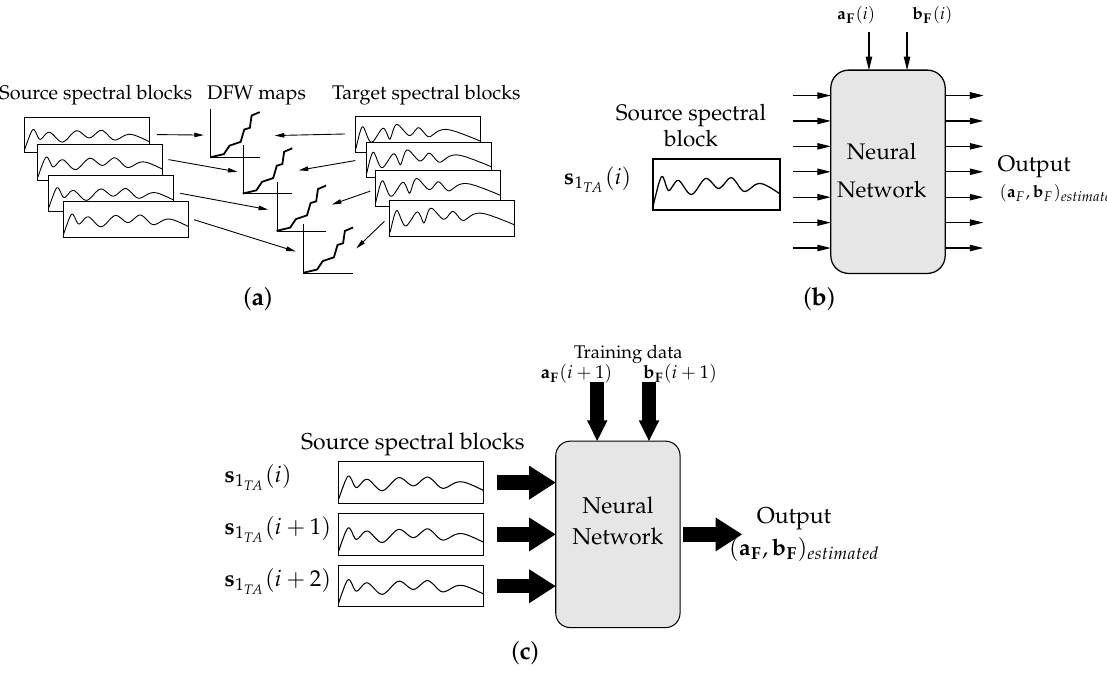
Figure 8. Spectrogram for male, female and warped male to female. ( a ) Making DFW training data. ( b ) Training a neural network—one input spectral vector. ( c ) Training a neural network—three input spectral